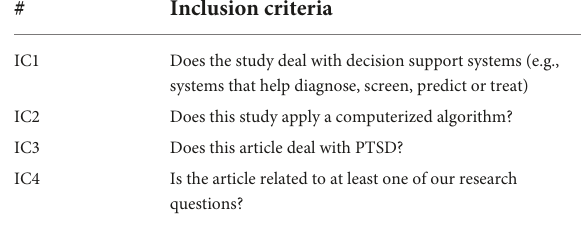
TABLE 1 Inclusion criteria.